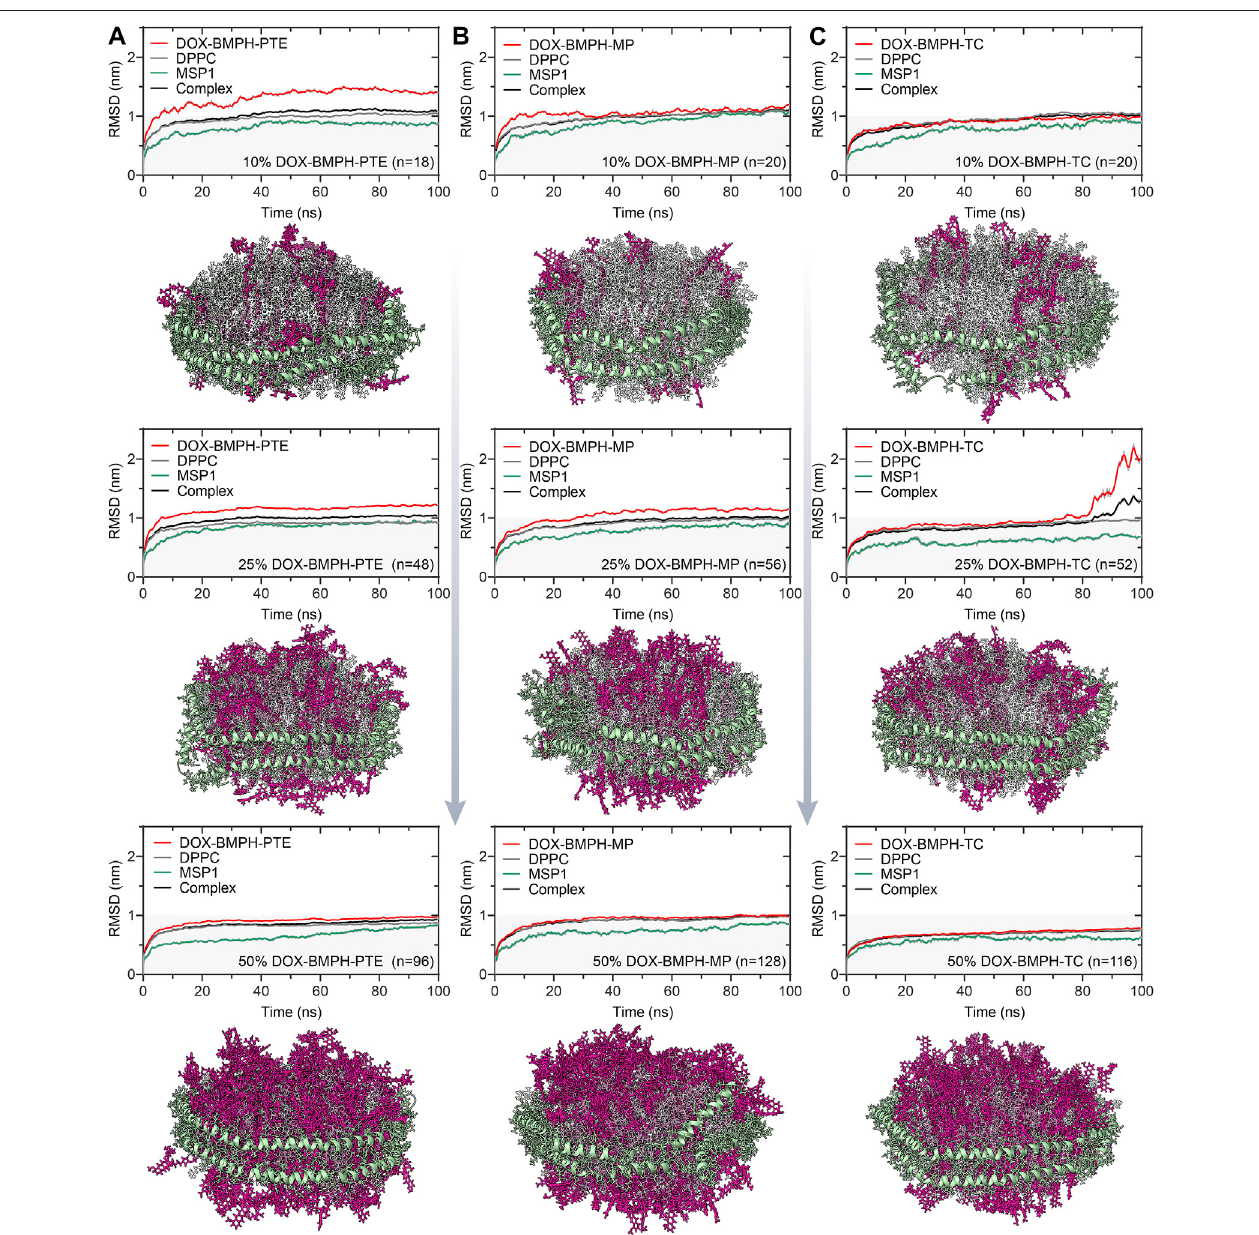
FIGURE 4 | MD simulation analysis of hydrogen bonds formed between DOX prodrug molecules and MSP1 protein in ND complexes. Dynamic measurements of hydrogen bond numbers in ND formulations of (A) DOX-BMPH-PTE (10%), DOX-BMPH-MP (10%), and DOX-BMPH-TC (10%). (B) DOX-BMPH-PTE (25%), DOX- BMPH-MP (25%), and DOX-BMPH-TC (25%). (C) DOX-BMPH-PTE (50%), DOX-BMPH-MP (50%), and DOX-BMPH-TC (50%). Dynamic measurements of hydrogen bonds per drug molecule in ND formulations of (D) DOX-BMPH-PTE. (E) DOX-BMPH-MP. (F) DOX-BMPH-TC. Electrostatic interactions between DOX prodrug molecules and MSP1 protein in ND formulations of (G) DOX-BMPH-PTE. (H) DOX-BMPH-MP. (I)